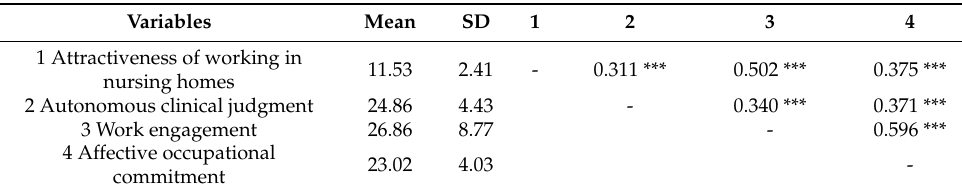
Table 2. Means and standard deviations for each study variable, and the correlation coefficients between these variables.